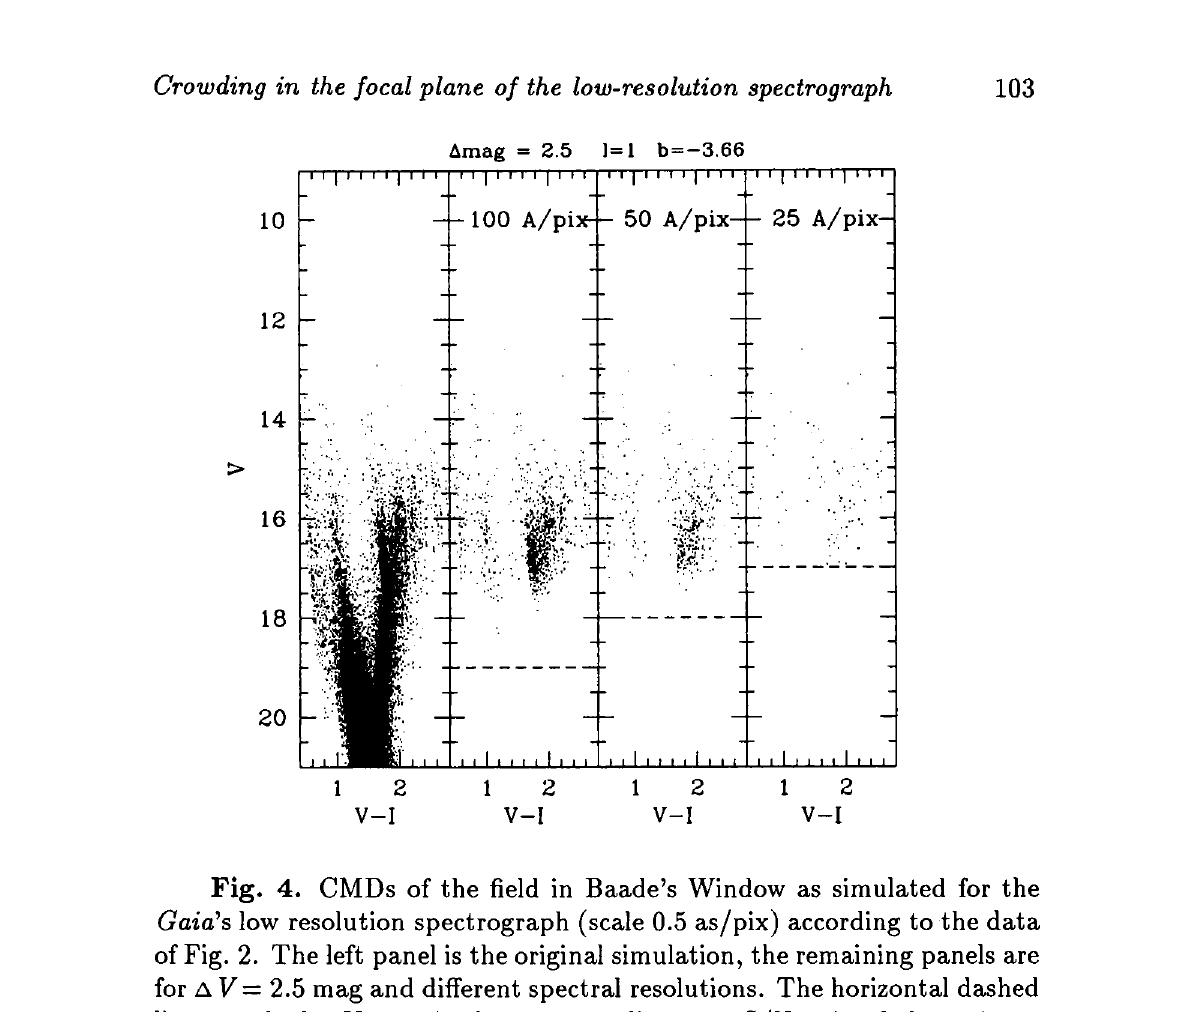
The horizontal dashed lines mark the V magnitude corresponding to a S/N ratio of about